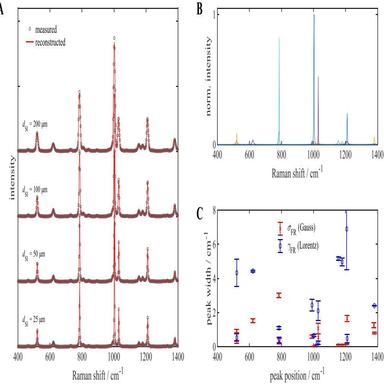
A) Unrestricted pure component reconstruction of toluene spectra from S3a) at different slit widths dSl based on the pure component model B). In C), peak widths and their standard deviations (from the most relevant peaks) resulting from the unrestricted reconstruction A) are given.